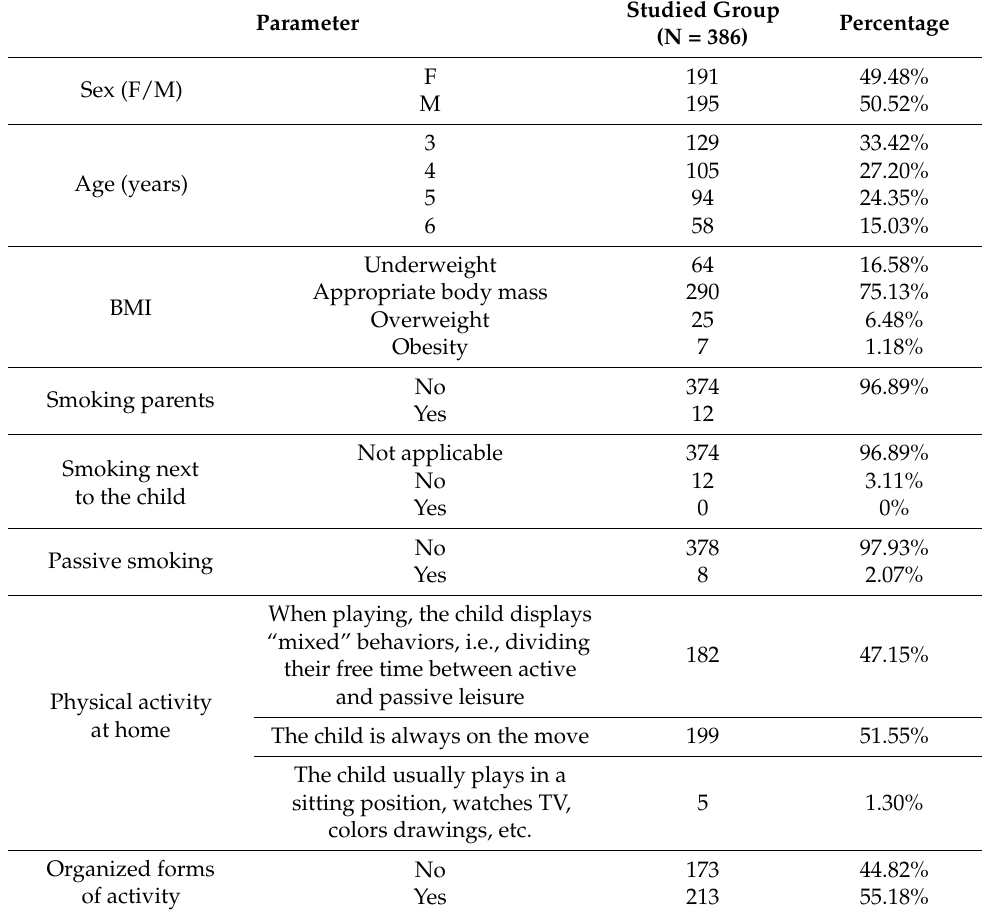
Table 1. Baseline characteristics of the study group.